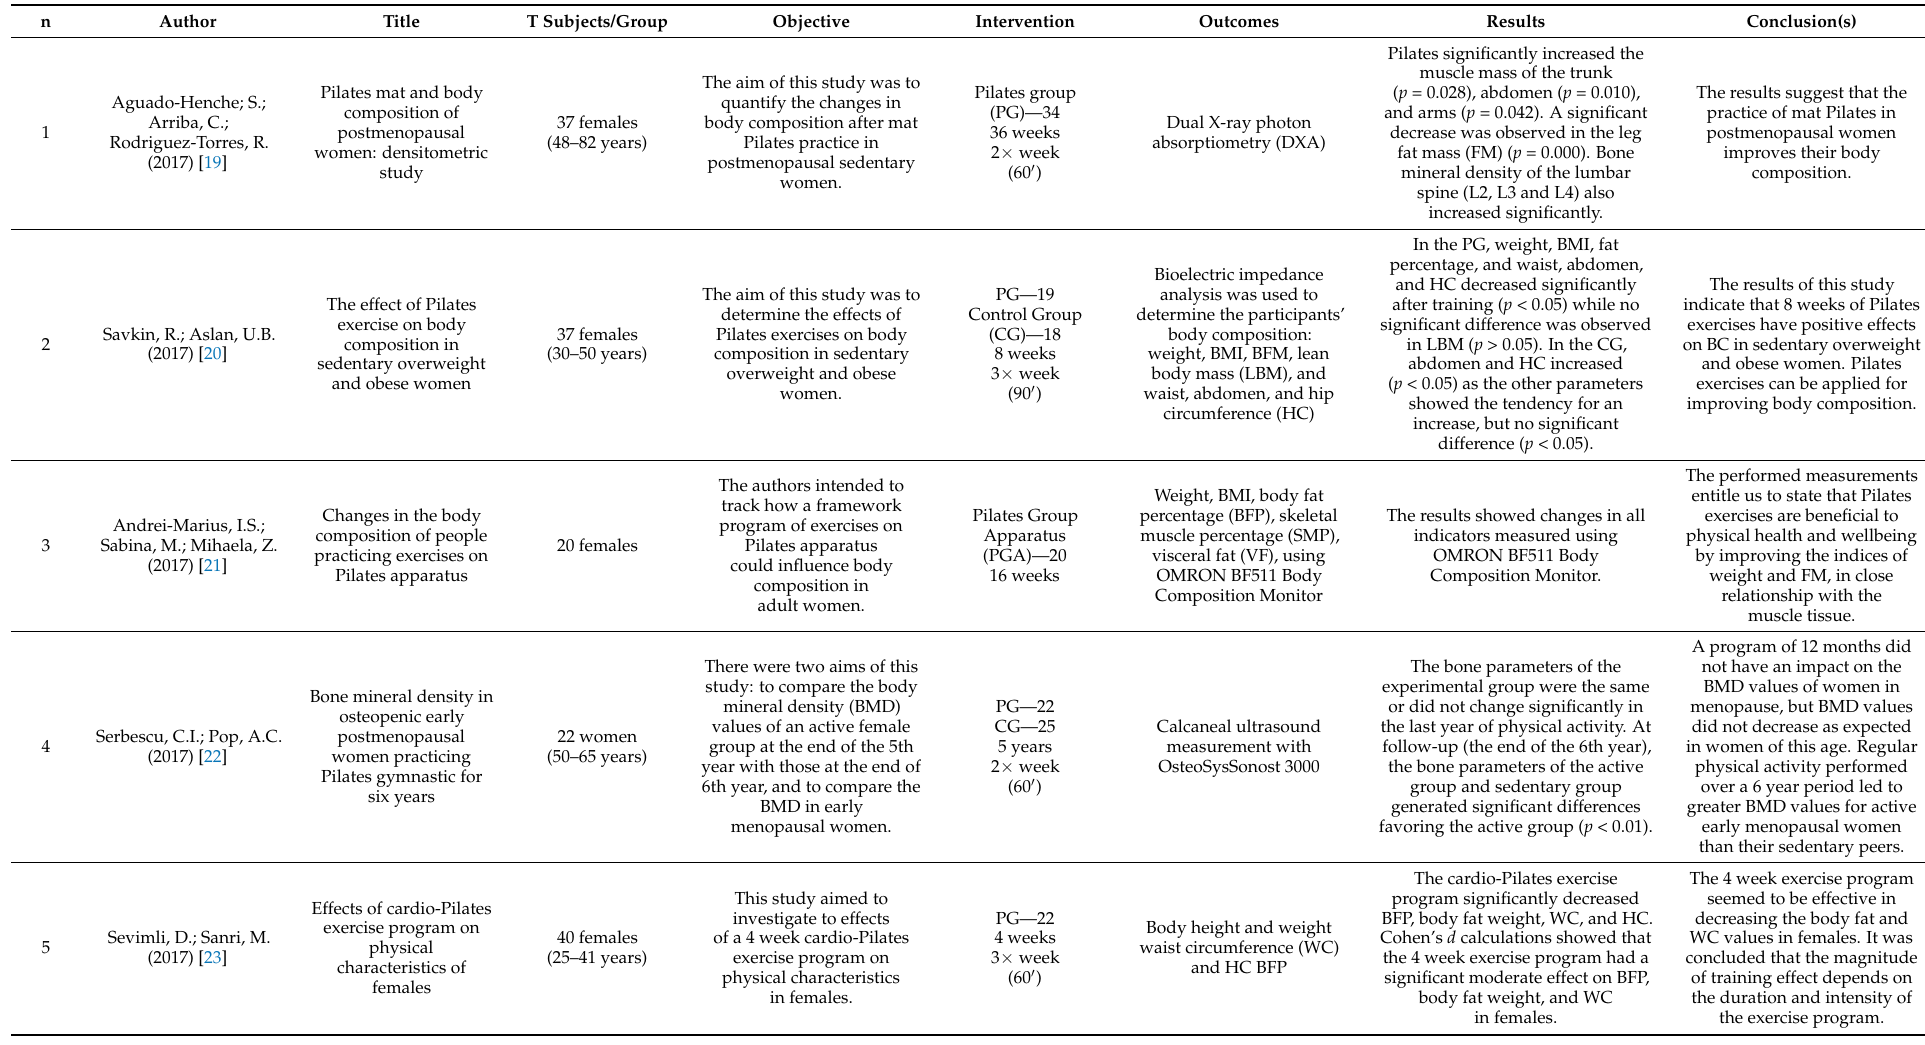
Table 1. Summary of studies included in the